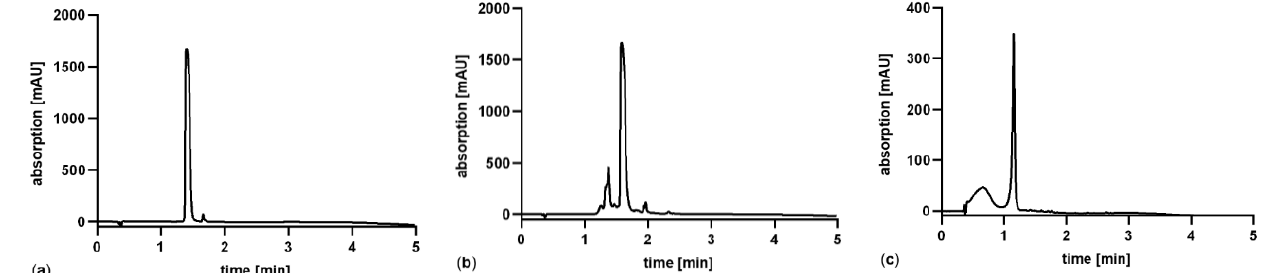
Figure 4. HPLC-analysis after acidic hydrolysis of aromatic amino acids ( a ) phenylalanine, ( b ) tryptophan and ( c ) tyrosine for 24 h at 120 °C. The original concentration of each amino acid prior hydrolysis was 1 mg/mL.